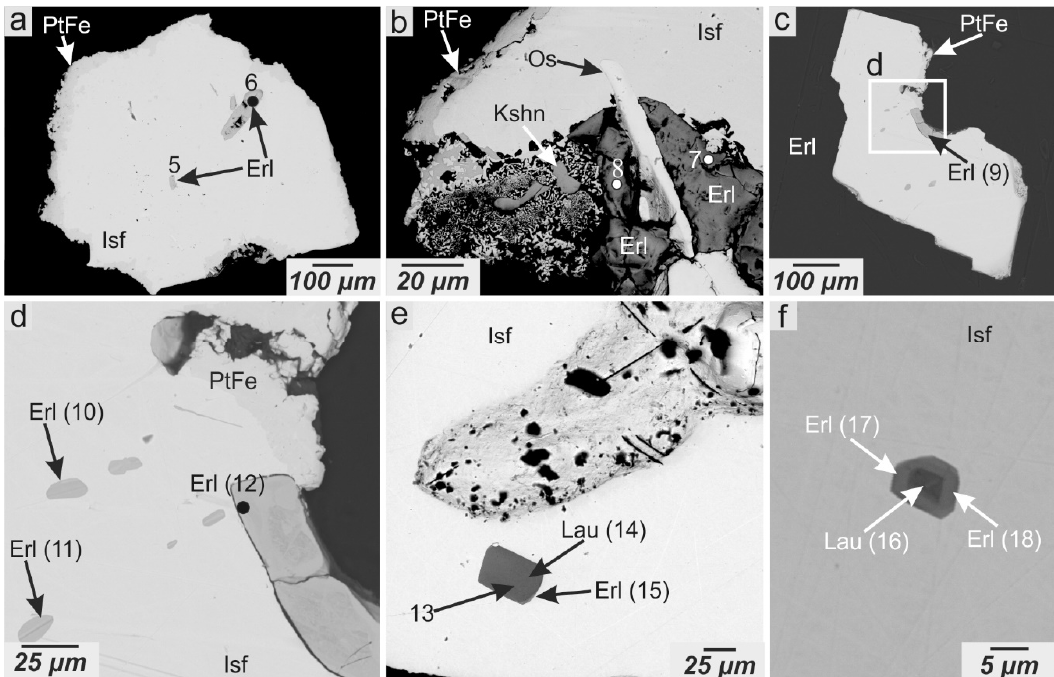
Figure 11. BSE images (SEM) of laurite–erlichmanite (Lau-Erl) in isoferroplatinum from ( a,b ) the Vershinniy eluvial placer, ( c,d ) the Travyanistyi proximal placer and ( e,f ) the Glubokinskoe distal placer. The number of points corresponds to the analyses in Table 5 (No. 5–18). Isf—isoferroplatinum, Pt-Fe—tetraferroplatinum, Erl—erlichmanite, Kshn—kashinite, and Lau—laurite. The a and b photo were published in Reference [25].